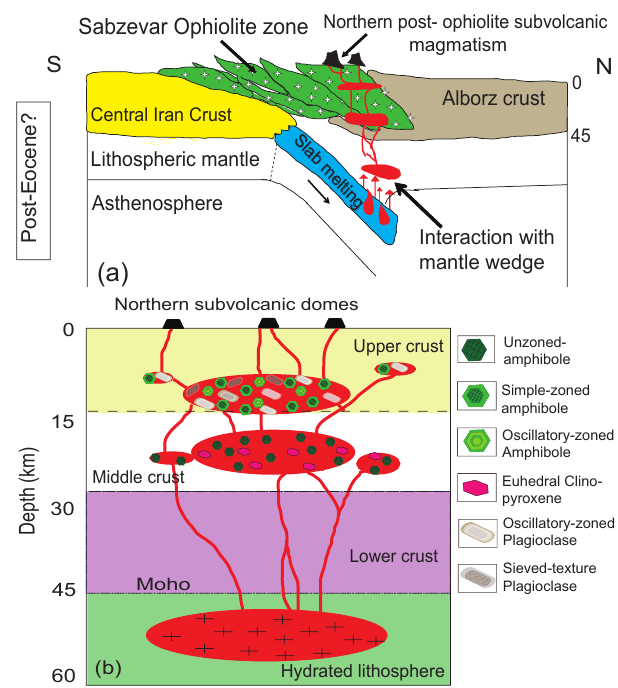
Fig. 17 Figure 17. (a) Tectonic framework illustrating northward subduc- tion of Sabzevar oceanic crust (eastern branch of Neotethys) be- neath the eastern Alborz zone. (b) Schematic illustration of the magma plumbing system for subvolcanic adakite-like rocks in the northern part of the Sabzevar belt based on the derived thermobaro- metric